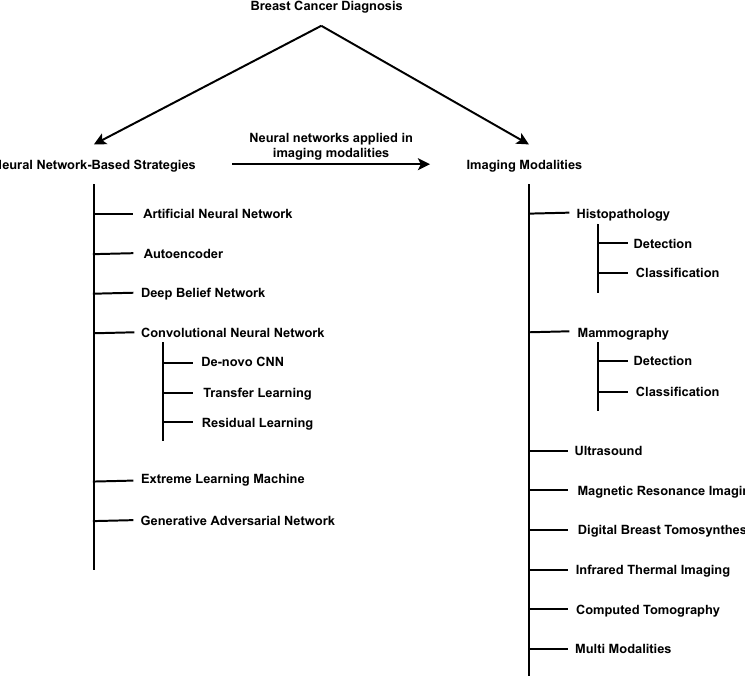
Figure 1. A taxonomy of deep-learning-based breast cancer diagnosis. Table 1. A comparison of existing surveys based on breast cancer diagnosis.